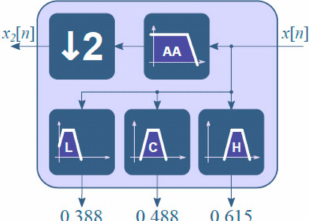
Figure 6. Base block used to build the bank filter. Frequencies are normalized to sampling frequency (Fs /